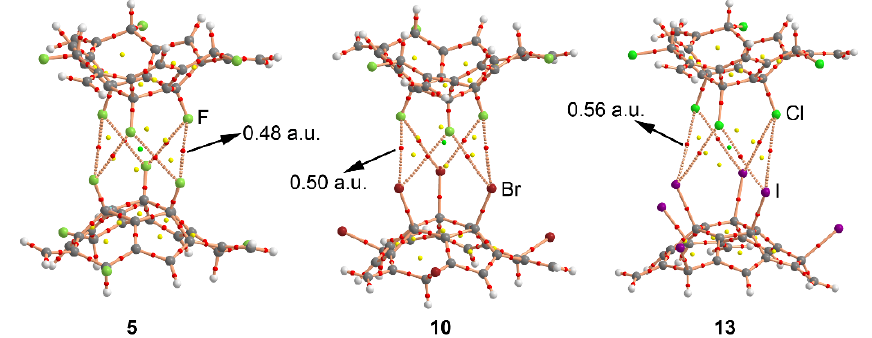
Figure 4. Distribution of critical points (red spheres) and bond paths for complexes 5 , 10 and 13 at the BP86/def2-TZVP level of theory. Bond, ring and cage CPs are represented by red, yellow and green spheres, respectively. The values of the charge density (ρ) at the bond critical points that emerge upon complexation are indicated in a.u.